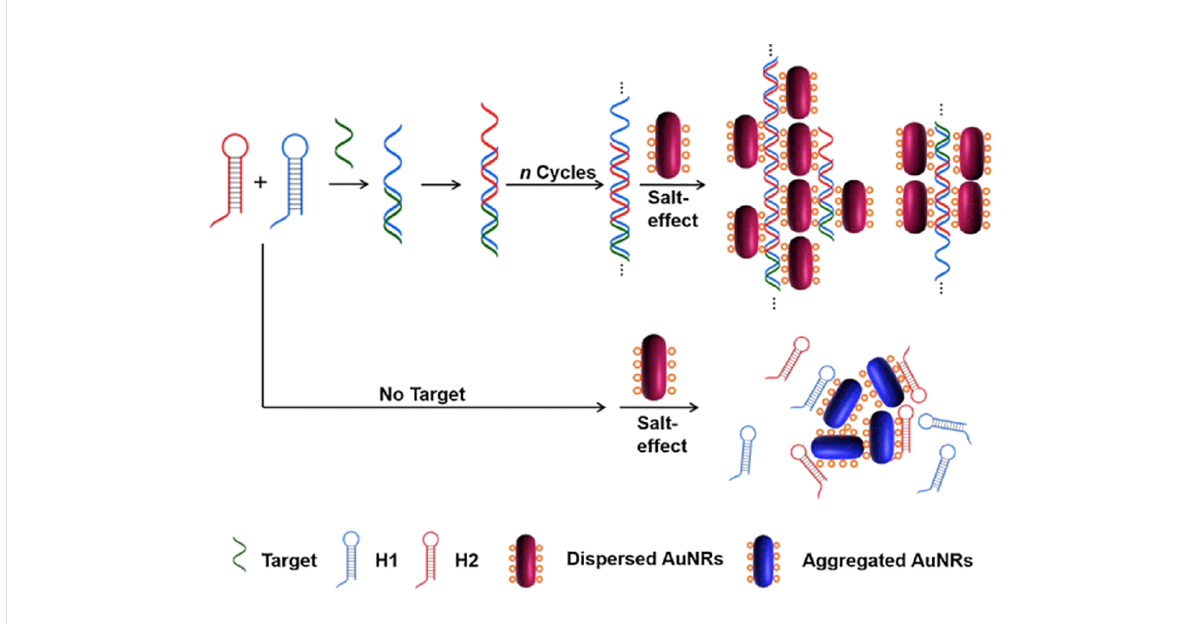
Figure 6: The combination of unmodified gold nanorods as signal transducers in an HCR amplification process for the colorimetric detection of single- base mutations. Reprinted with permission from [82], copyright 2018